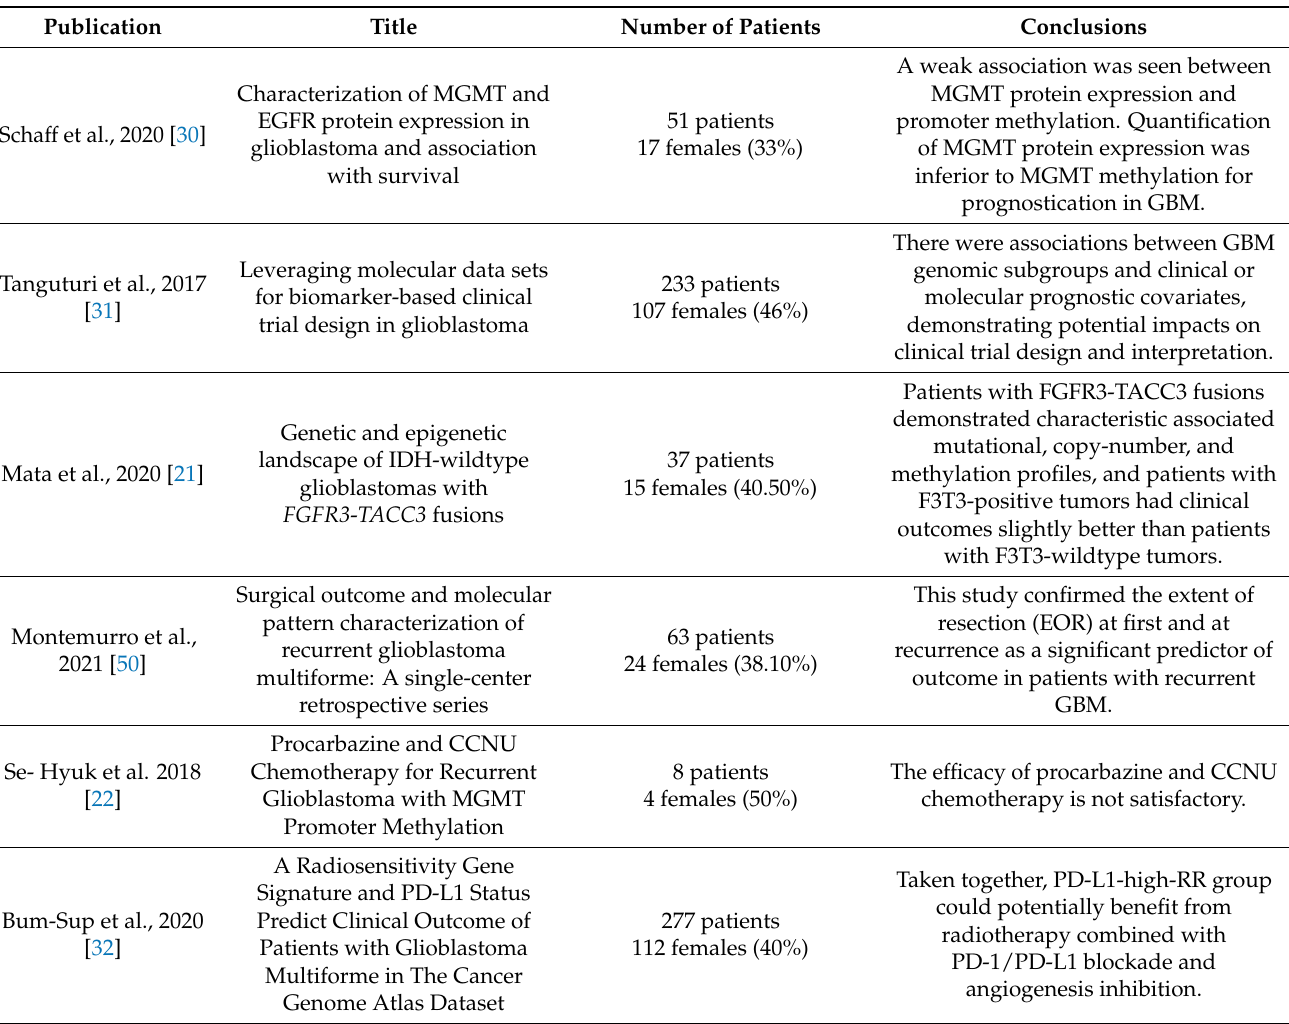
Table 1. Retrospective studies in glioma illustrating the number of patients included in the study with % female inclusion and generated